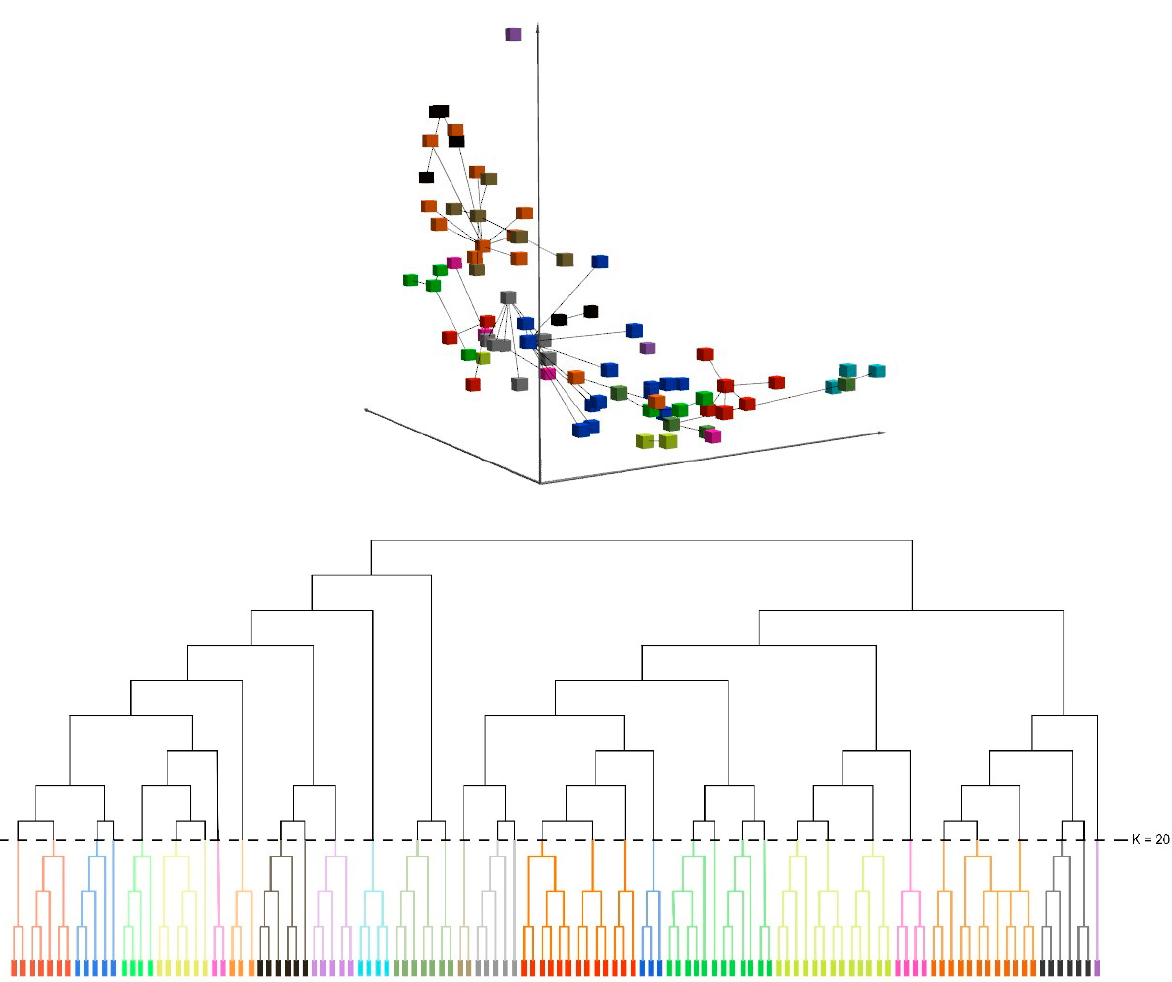
Figure 15. The hierarchical clustering of the pareto front solutions with a K-value of 20, presented through the objective space and dendrogram. As the problem comprised of four fitness functions, it is difficult to read the cluster distribution in the objective space (which is 3-dimensional). In this case the dendrogram provides a clearer understanding of the relationship between solutions, both within and between clusters.